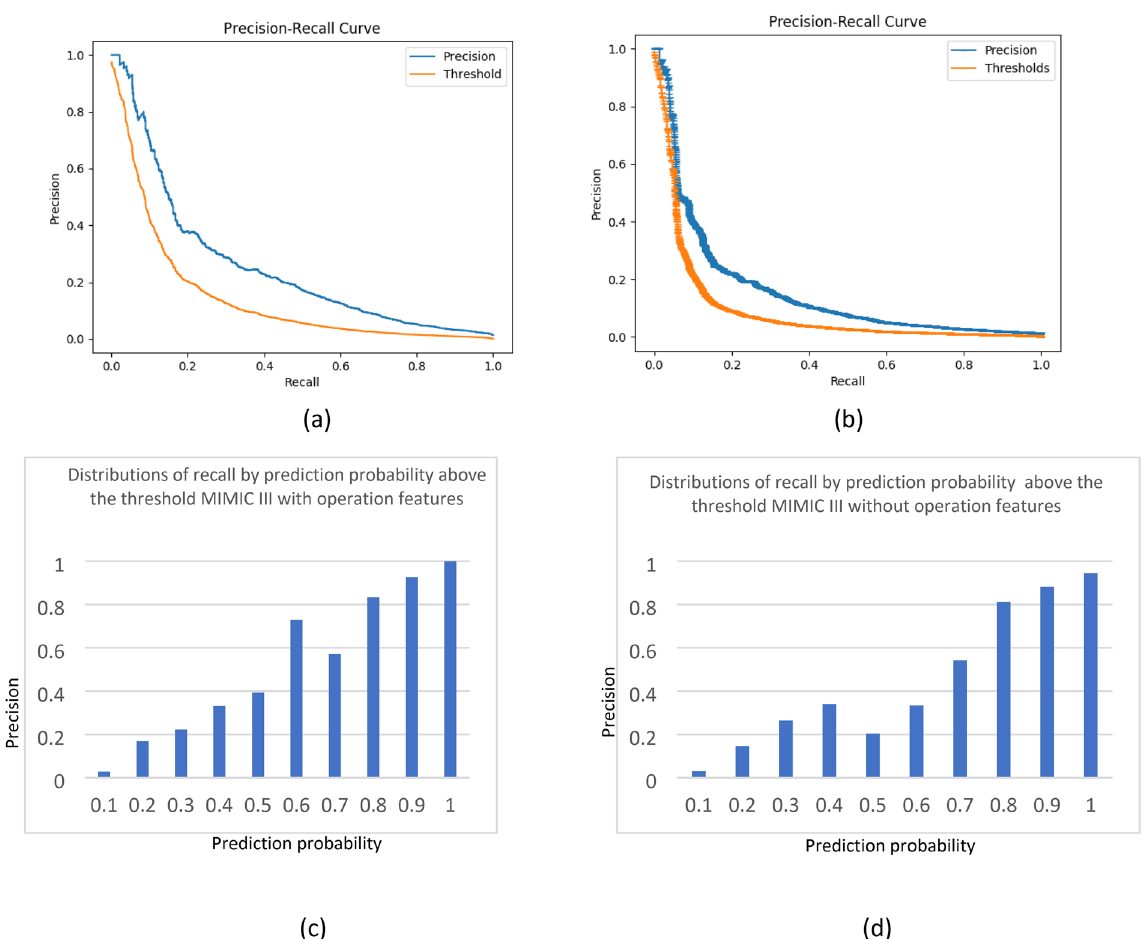
Figure 5. Precision-recall curves and distributions of precision by prediction probability above the threshold. ( a , c ) Training on MIMIC III with operational features. ( b , d ) Training on MIMIC III without operational features. Figures ( c ) and ( d ) were built as follows: prediction probability interval above the threshold was divided into the intervals [ µ , 0.1], [0.1, 0.2], … , [0.9, 1]. The chosen threshold ( µ) for prediction probability corresponds with 20% of false positives. Precision was calculated for each interval